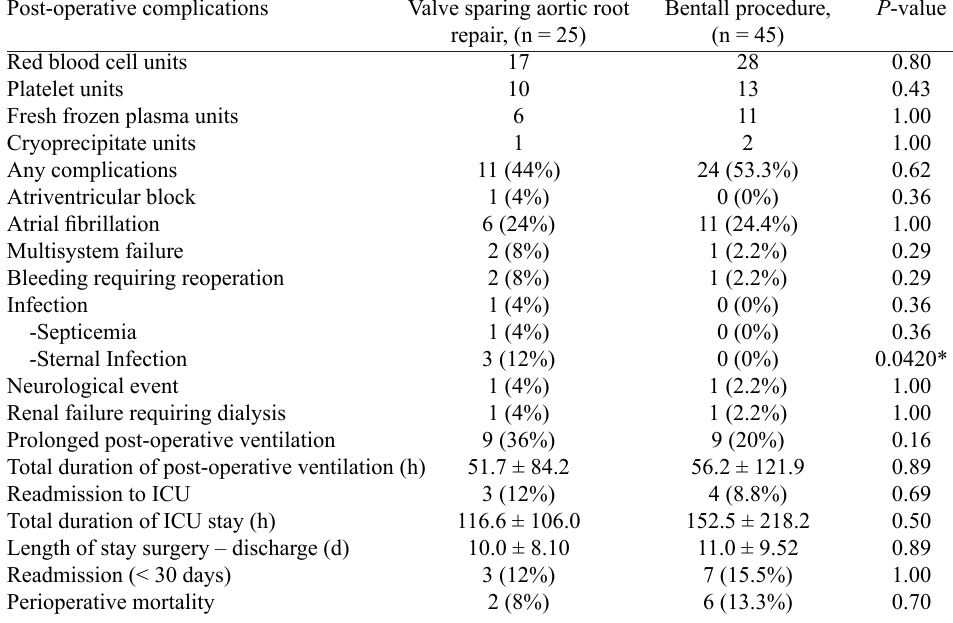
Table 3. Postoperative outcome and